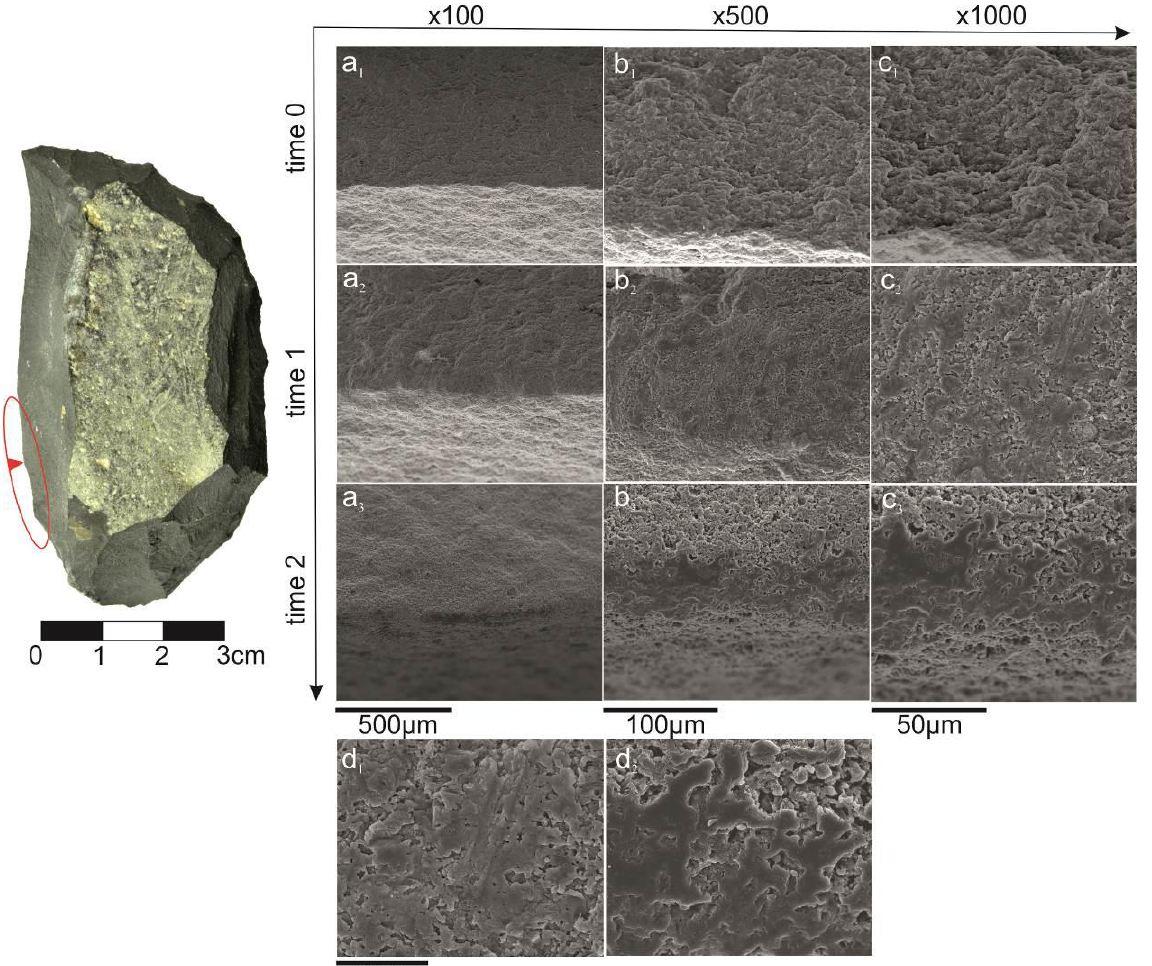
Figure 8. Microscopic study of Ishbas1-HS1 used edge (ventral face) seen under the SEM; circle indicates the most used portion of the edge and the arrow shows the exact point at which these images were taken: (a – a ) 1 3 the same portion of the unused edge (a ), after 20 minutes (a ) and after 50 minutes (a ) of use at x100 1 2 3 magnification; (b – b ) the same portion of the unused edge (b ), after 20 minutes (b ) and after 50 minutes (b ) 1 3 1 2 3 of use at x500 magnification; (c – c ) the same portion of the unused edge (c ), after 20 minutes (c ) and after 1 3 1 2 50 minutes (c ) of use at x1000 magnification; (d – d ) a detail of use-wear traces after 20 minutes (d ) and after 3 1 2 1 50 minutes (d ) of use at x2000 2